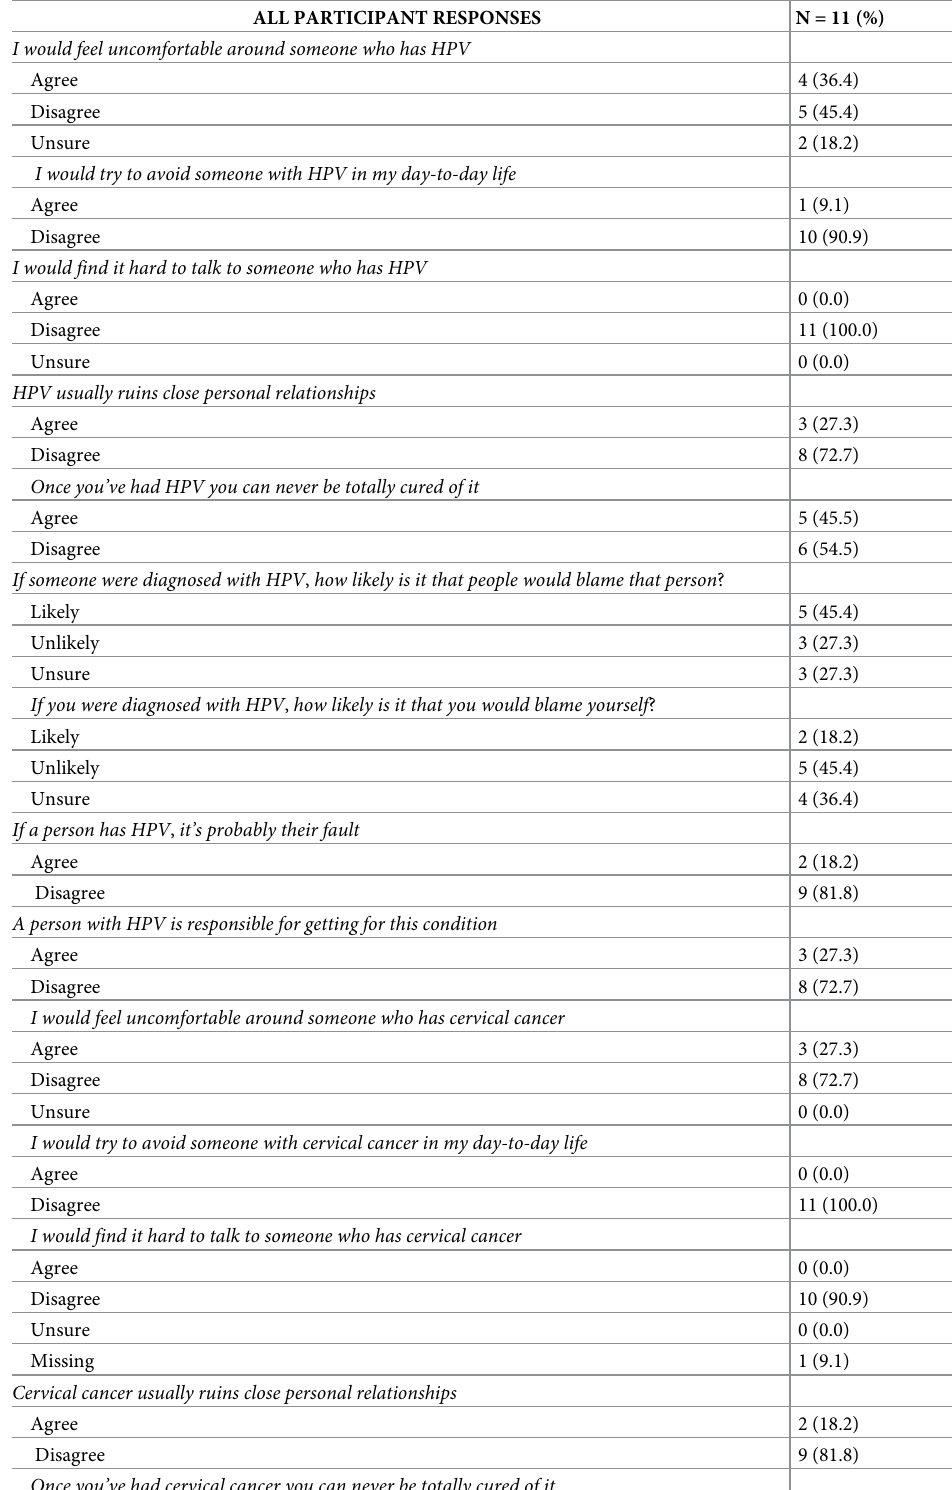
Table 4. Stigma related to cervical cancer prevention